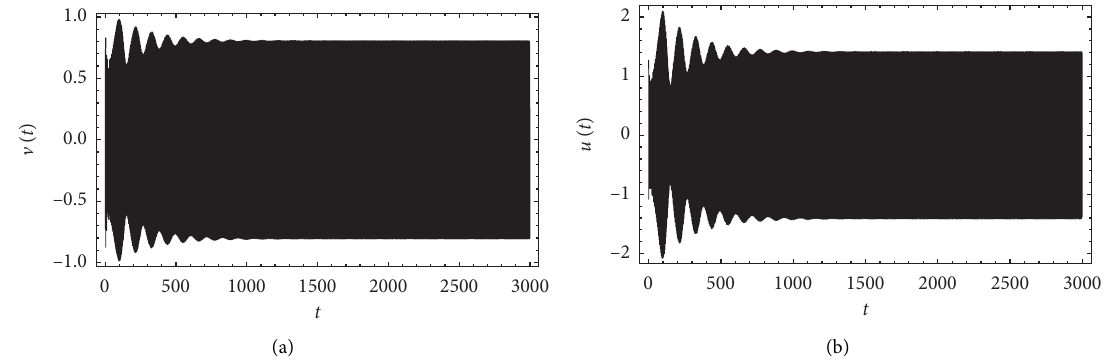
� 0 . 02 , τ � 0 . 01 , σ � 0 . 28 ,y � 0 . 07 with the initial condition 1 2 1 0